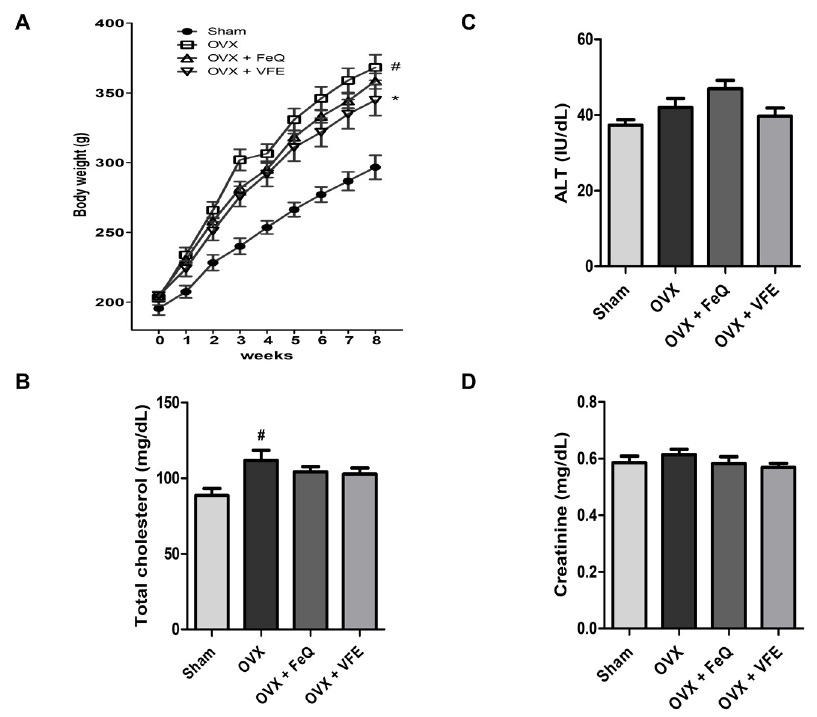
Figure 4. Effects of VFE on the body weight, cholesterol level, and liver and kidney toxicity mark- ers of ovariectomized (OVX) rats. ( A ) Change in body weight. ( B ) Levels of plasma cholesterol. ( C ) Plasma ALT levels. ( D ) Plasma creatinine levels. The data are expressed as mean ± SEM. Statistical significance was evaluated and determined by a one-way analysis of variance (ANOVA), followed by the Tukey’s post-hoc test. # p < 0.05 vs. sham, * p < 0.05 vs. OVX.